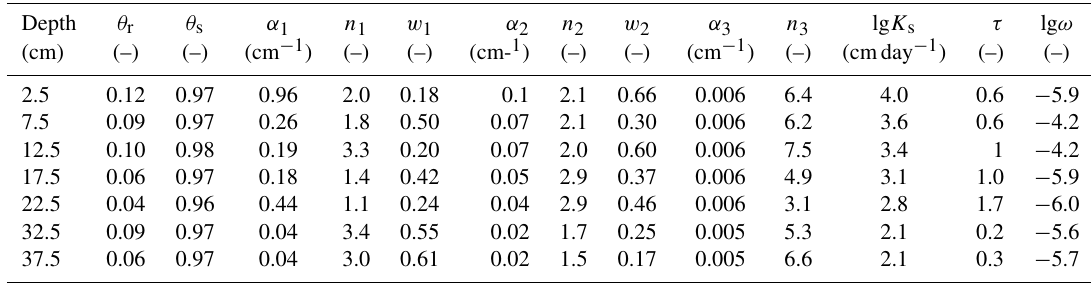
Figure 7. (a) Trends of key pore-system characteristics with depth: (a) near-exponential decrease in K s with depth, (b) decrease in charac- teristic pore diameter with depth, expressed as the median pore diameter d 50 of the second modality, and (c) reduction of the width of the pore-size distribution with depth, expressed by d 75 /d 25 . Table 2. PDI3-model parameter ∗ values of the depth-averaged effective soil hydraulic properties. Depth